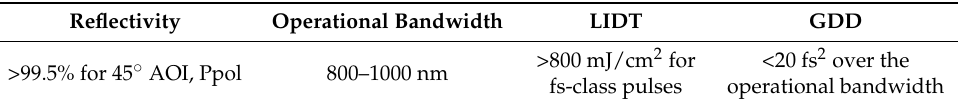
Table 1. Broad bandwidth high reflection (BBHR) coating design